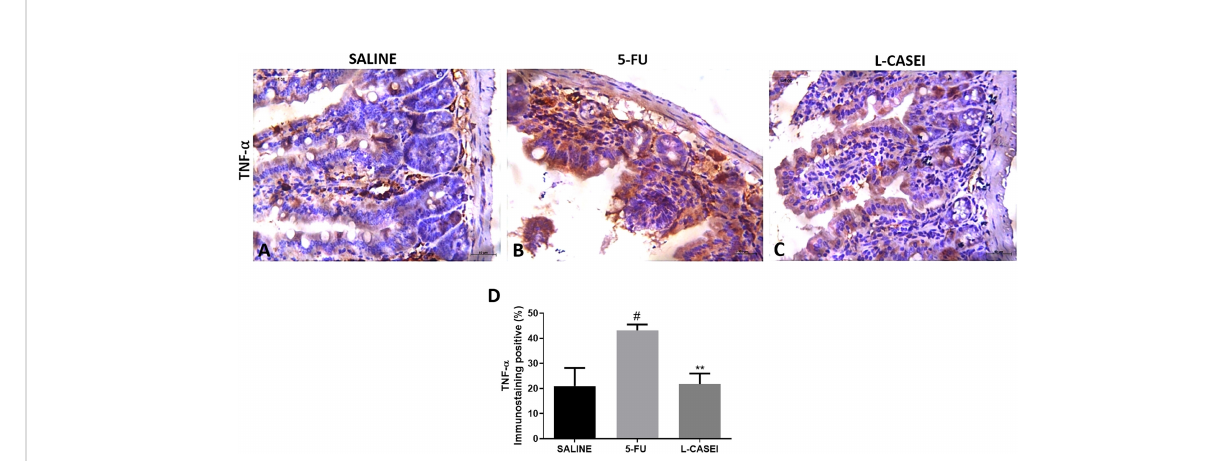
FIGURE 5 Representing examples of TNF- a immunostaining: Control (Saline; A ), 5-FU (B) ; L. casei (LC; C ) and percentage of TNF- a immunolabeled cells (D) . Values were expressed as mean ± SEM. For statistical analysis, one-way ANOVA was used followed by Tukey ’ s test, where # p < 0.001 vs. control group, **p < 0.01 vs. 5-FU group. Magni fi cation x400.